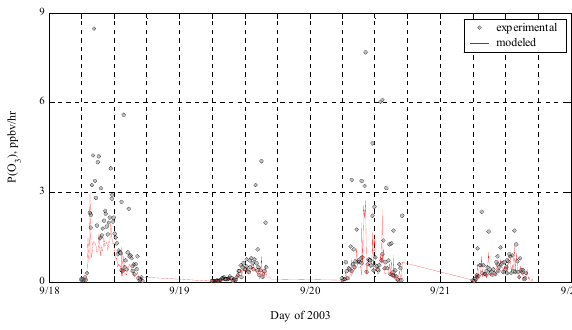
Fig. 10. Time series of experimental and modelled P (O 3 ) in 10-min averages during 18–21 September, 2003.